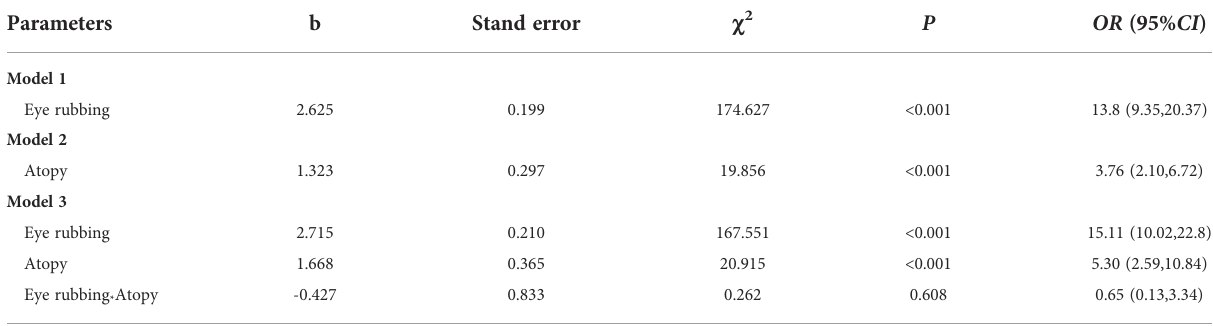
Model 3, multivariate regression involving eye rubbing, atopy and eye rubbing *